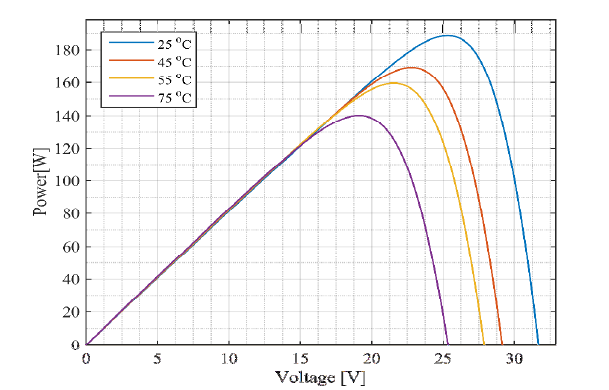
Fig. 1. Dependence of the Photovoltaic power output on panel operating